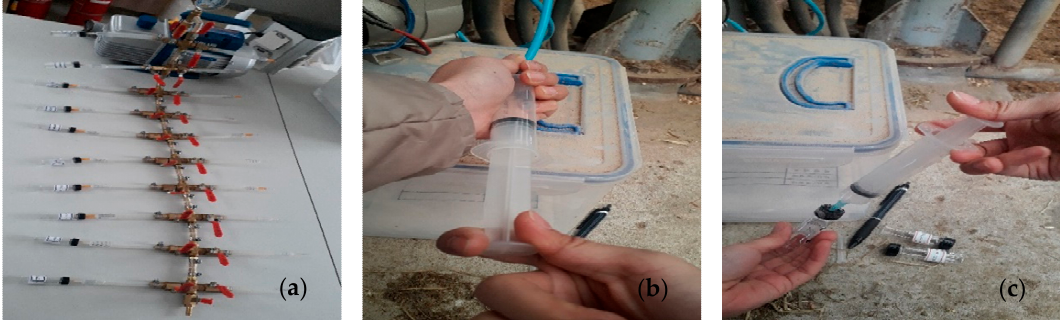
Figure 3. Gas sampling procedure: ( a ) vacuuming the glass vial, ( b ) taking gas sample using the syringe, ( c ) transferring gas sample to vacuumed glass vial.